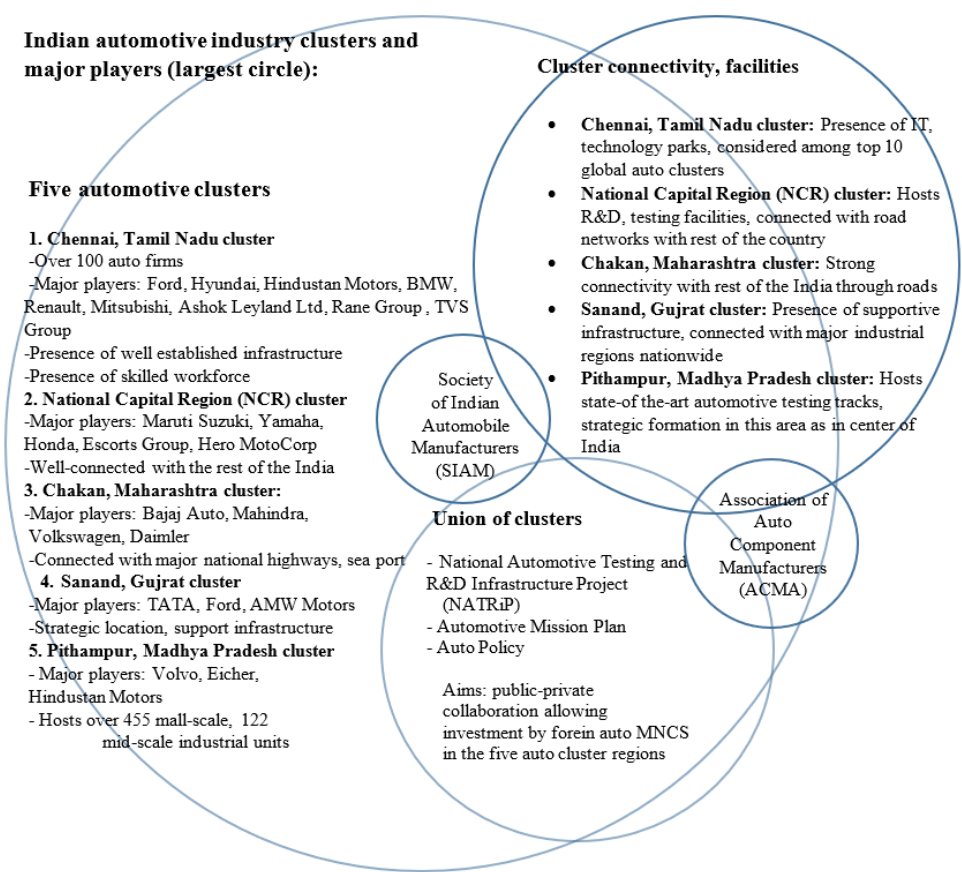
Figure 3. The networks of India’s automotive clusters, firms and associations. Sources: ACMA (2018), Okada and Siddharthan (2008), SIAM (2018).